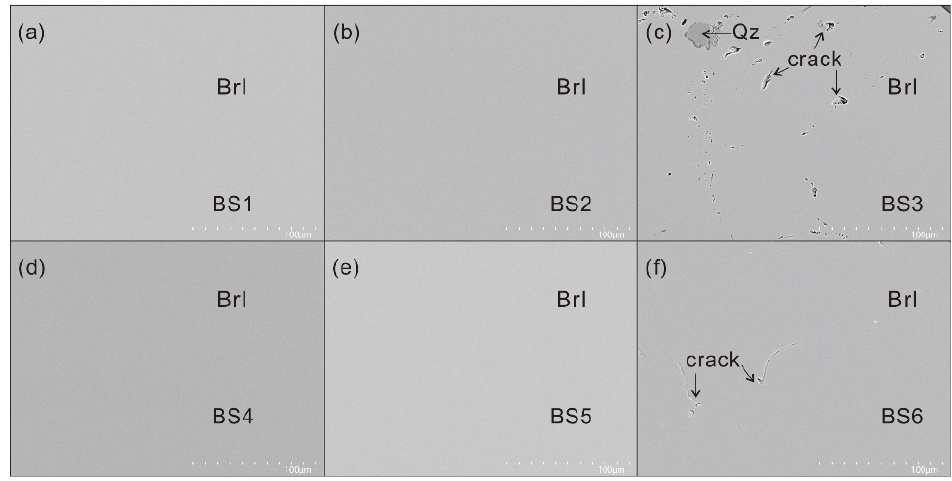
Figure 2. Representative BSE images of the beryl samples used in this study: ( a ) BS1, ( b ) BS2, ( c ) BS3, ( d ) BS4, ( e ) BS5, and ( f ) BS6. Brl, Beryl; Qtz, quartz.